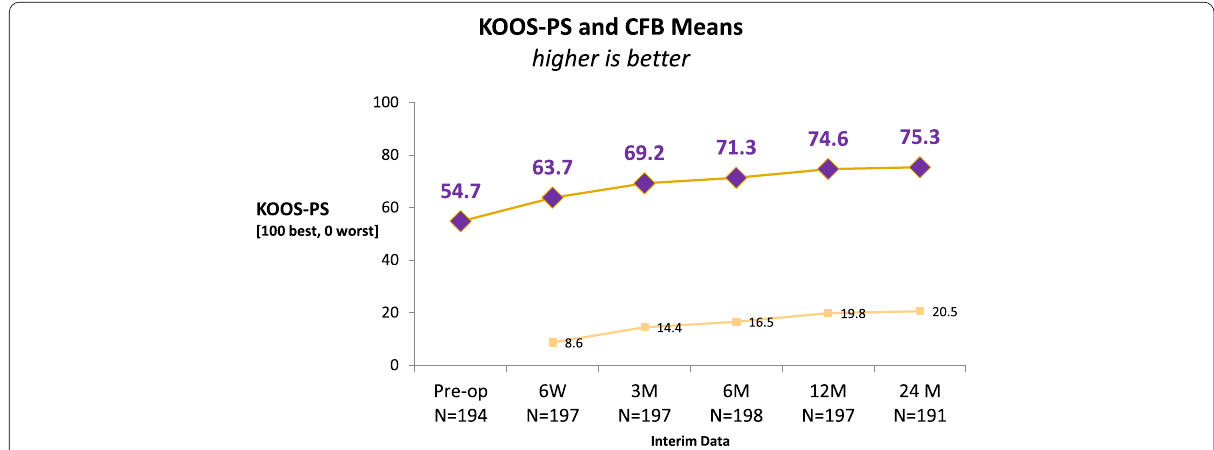
Fig. 1 KOOS-PS (top) and CFB (bottom)